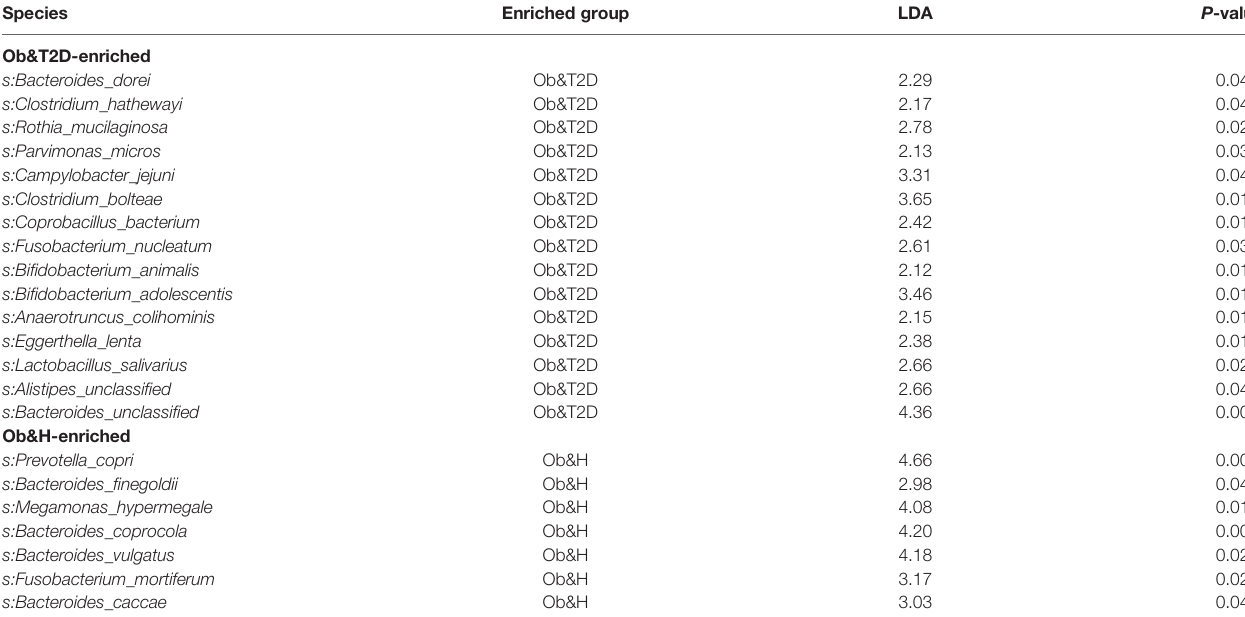
TABLE 2 | List of Ob&T2D- and Ob&H-enriched species from metagenomic sequencing data. Species Enriched